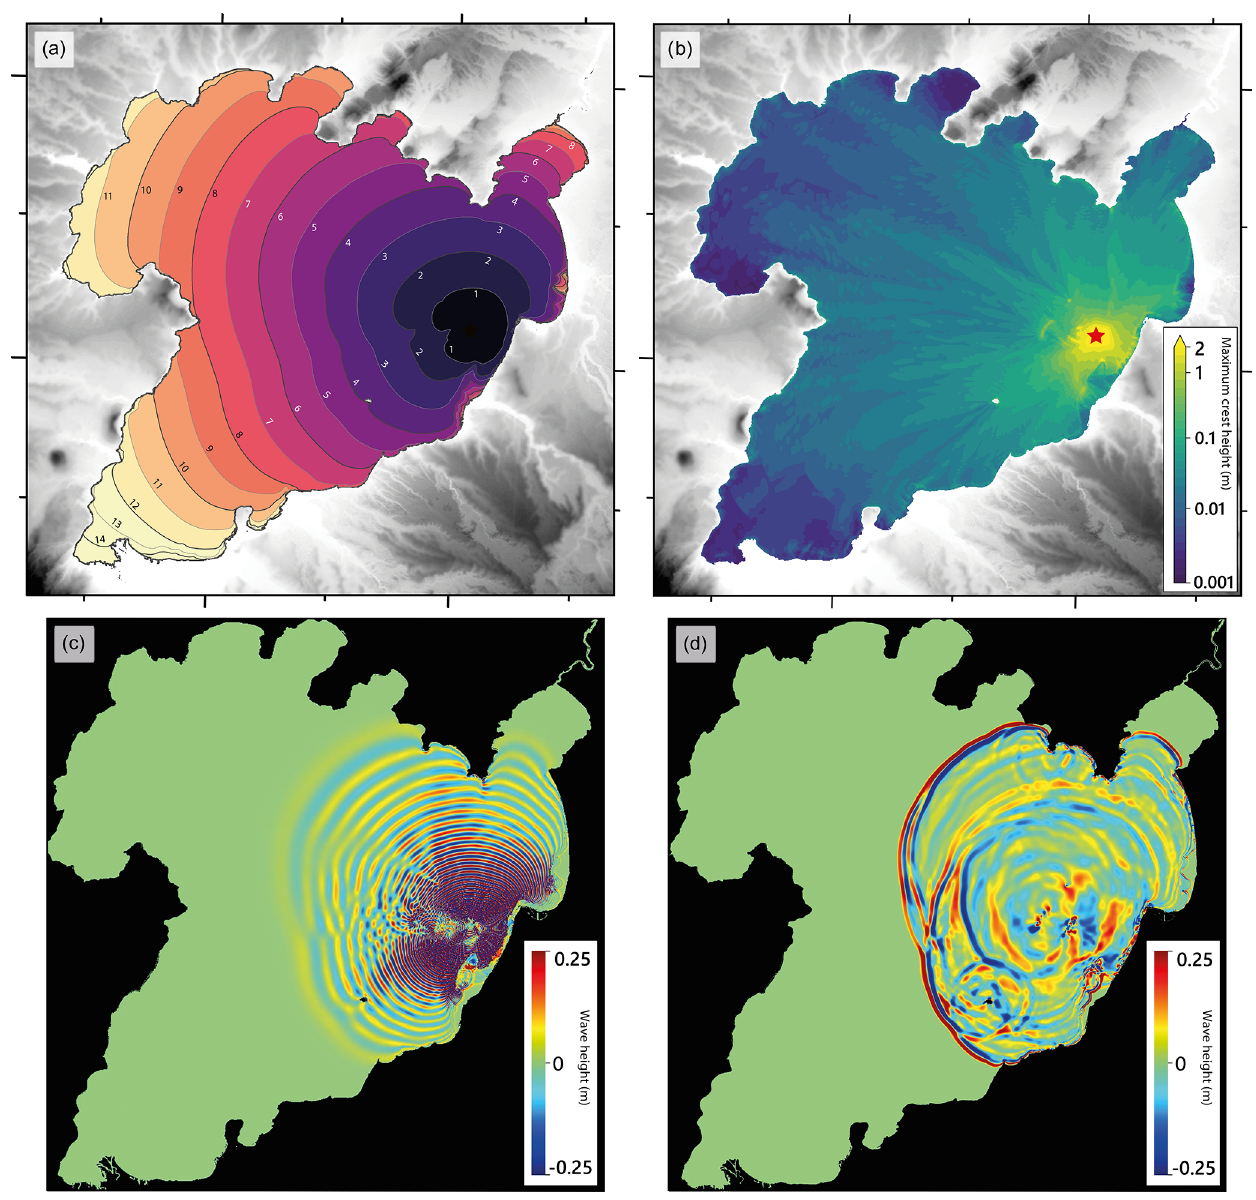
Figure 10. Multilayer simulation of potential volcanic explosion in Lake Taup ¯ o. (a) First arrival travel times in minutes. (b) Field of maximum crest amplitudes. (c) Snapshot of wave amplitudes at t = 4 . 5min. (d) Equivalent of (c) but using the Saint-Venant